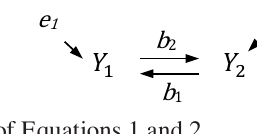
Path Model of Equations 1 and